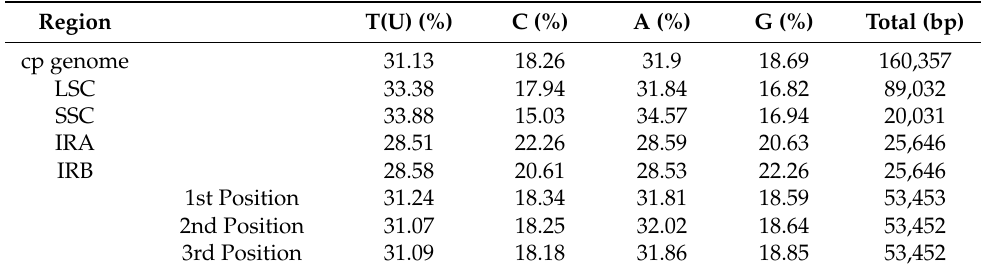
Figure 1. Gene map of the A. fruticosum chloroplast genome. Genes outside the circles are transcribed in the counter- clockwise direction and those inside in the clockwise direction. Known functional genes are indicated by colored bar. The GC and AT contents are denoted by the dark gray and light gray colors in the inner circle, respectively. LSC indicates large single copy; SSC indicates small single copy; and IR indicates inverted repeat. Table 1. Base composition in the A. fruticosum chloroplast genome.